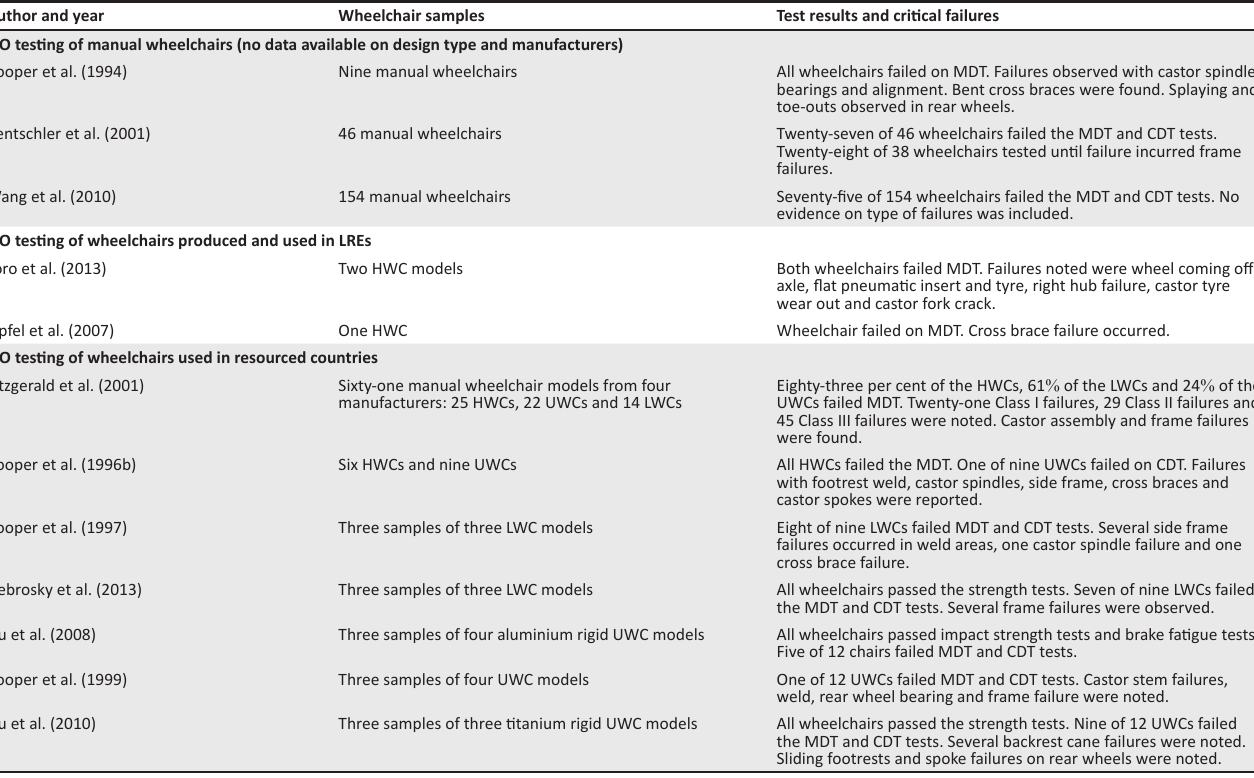
TABLE 1: Findings from the International Organization for Standardization standard testing studies of manual wheelchairs. Author and year Wheelchair samples Test results and critical